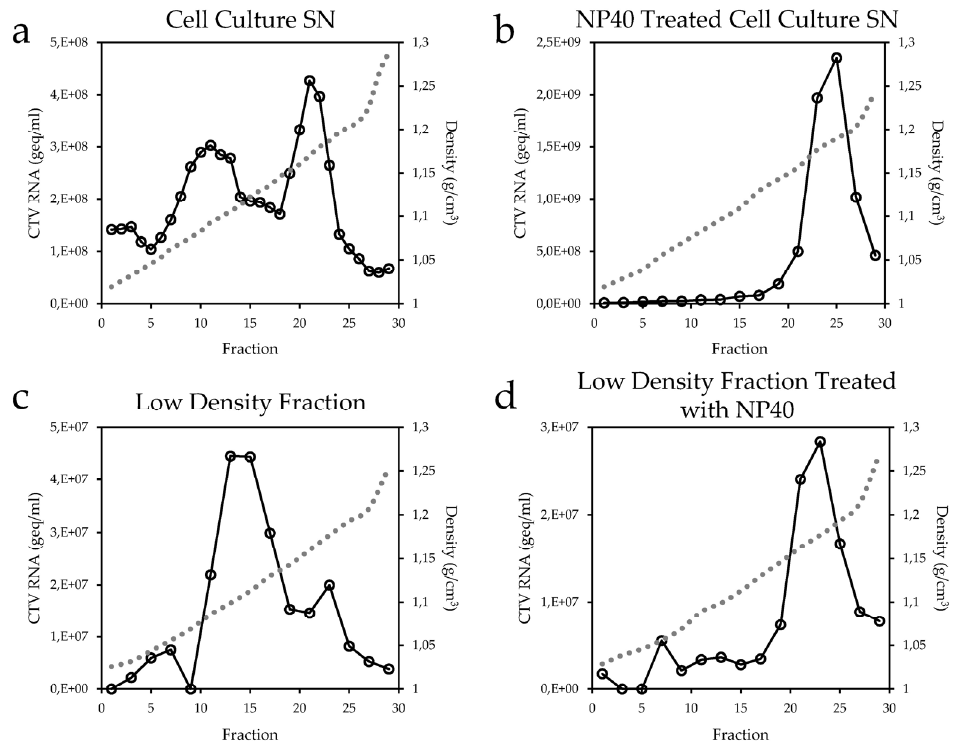
Figure 5. CTV produced in cell culture is associated to lipids. CTV RNA ( ) was quantified by RT ‐ qPCR and the density ( ) of each fraction was measured by refractometry. ( a ) Iodixanol density gradient of CTV from cell culture SN; ( b ) Treatment of cell culture SN with 1% NP40; ( c ) Fractions 10 and 11 of the low ‐ density fraction from (a) were pooled and re ‐ centrifuged; ( d ) The same fraction used for (c) was pretreated with 1% NP40 and re ‐ centrifuged.